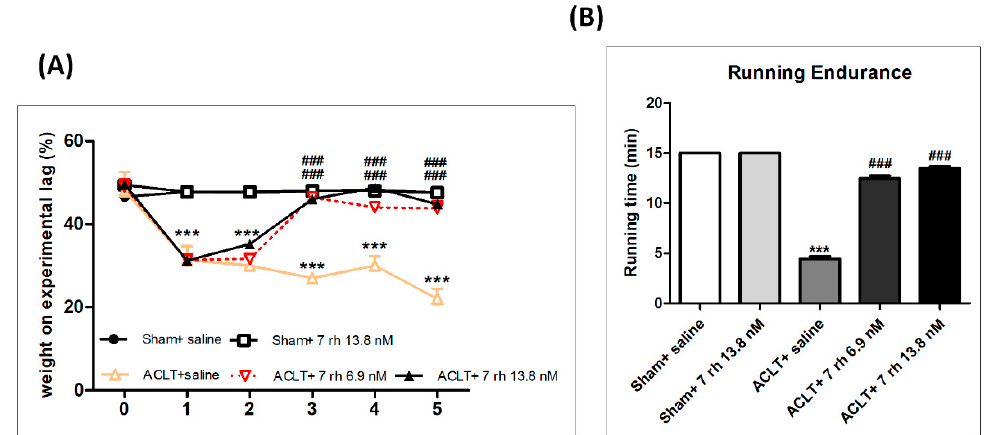
Figure 2. Treatment with 7 rh promoted knee function after anterior cruciate ligament transection (ACLT). ( A ) Weight-bearing test. There were no obvious influences in both of the sham control groups ( sham+ saline and sham+ 7 rh 13.8 nM ) during the treating courses. The weight-bearing ability of the studied limb was significantly reduced after osteoarthritis (OA) induction ( p < 0.001). Mice in the OA + 7 rh group could bear significantly more weight since the third week ( p < 0.001 at both concentrations) and thereafter until the end of the study (all p < 0.001). ( B ) Treadmill running test. The mice in the ACLT-OA group could endure less time in gait occurred than those in the sham control groups ( p < 0.001) at 5 weeks. In both treating groups, the mice significantly increased their running endurance in the treadmill test (all p < 0.001) with no significant difference from mice in the sham control groups. (*** p < 0.001 versus the sham control groups; ### p < 0.001 versus the ACLT group).